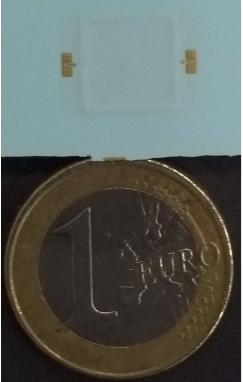
Figure 9. Photo of the CSIW resonator prototype.